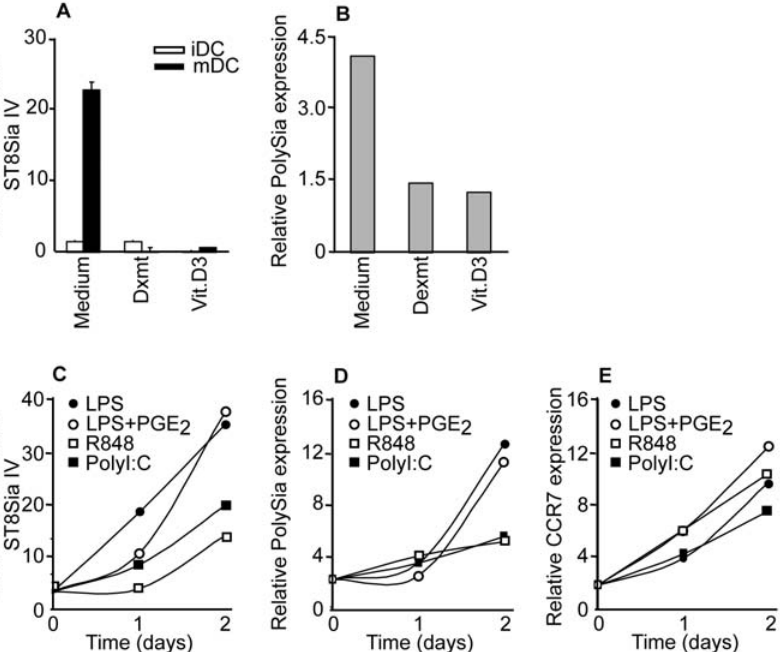
Figure 3. Polysialic acid and CCR7 expression levels on different DC subsets. (A) Expression levels of ST8Sia IV (N=3) and (B) polySia expression of immunogenic mDCs and dexamethasone or vitamin D3 tolerogenic mDCs, as measured by RT-PCR and flow cytometry respectively. One representative donor out of three is shown. (C) ST8Sia IV expression levels in time of DCs matured with different TLR ligands as measured by RT- PCR. (D) PolySia expression levels in time on DCs matured with different TLR ligands as measured by flow cytometry with mAb 735. One representative donor is shown. (E) CCR7 expression levels in time on DCs matured with different TLR ligands were measured by flow cytometry. One representative donor is shown. For all experiments the relative antibody binding compared to the secondary antibody control is depicted.